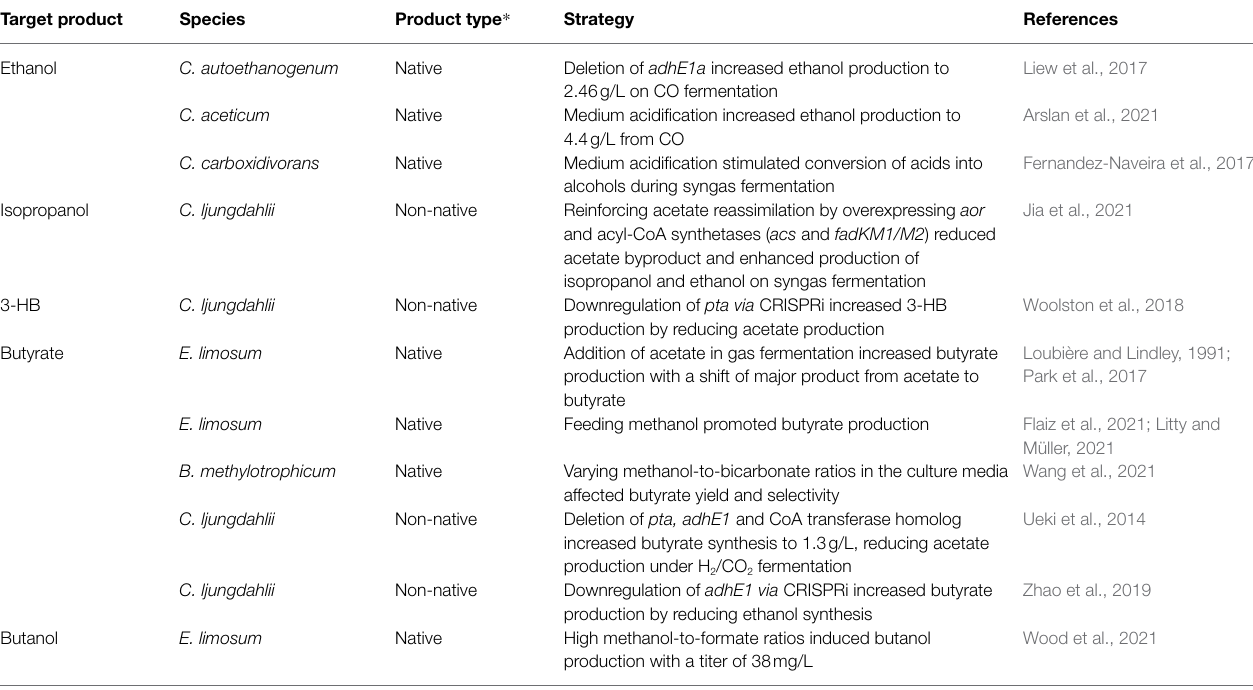
TABLE 2 | Strategies to improve product selectivity of native or non-native biochemicals in acetogens. Target